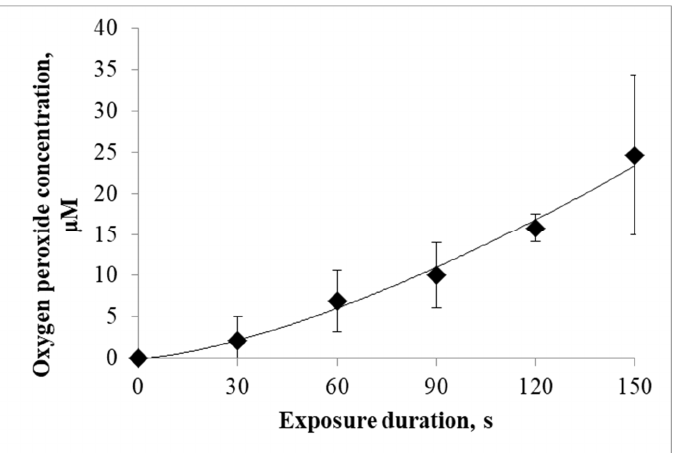
Figure 4. Dependence of oxygen peroxide concentration in the physiological solution on the pro- cessing time by direct piezodischarge. The distance between the piezotransformer and the solution surface was 0.5 mm. The temperature of the surrounding medium was 20 ± 2 ◦ C, and the air humidity was 70 ± 3%. In detail, the experimental conditions are described in the Section